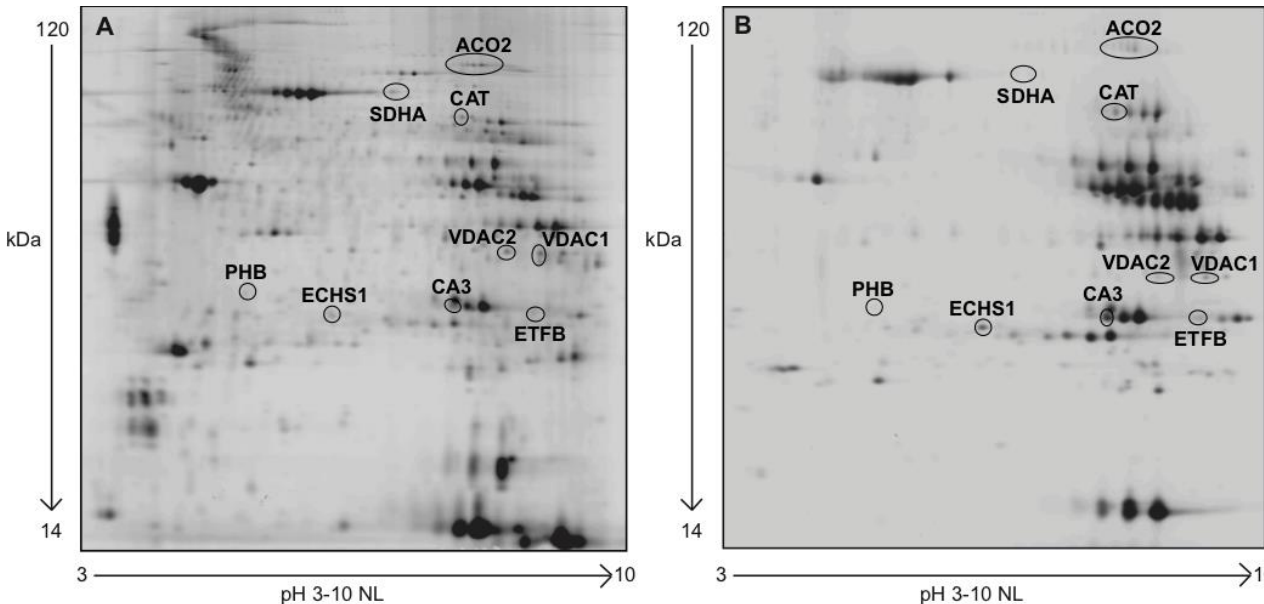
Figure 3. Representative VL muscle protein nitroprofiles. ( A ) Individual 2D pattern gel image of 40 μg of protein extract, separated in a pH 3 – 10 non-linear immobilized pH-gradient (IPG) in the first dimension, and SDS gel (12% T, 2.5% C) in the second dimension. ( B ) NITRO- DIGE gel image of 20 μg of protein extract, separated in a pH 3 – 10 non-linear IPG strip in the first dimension and SDS gel (12% T, 2.5% C) in the second dimension.